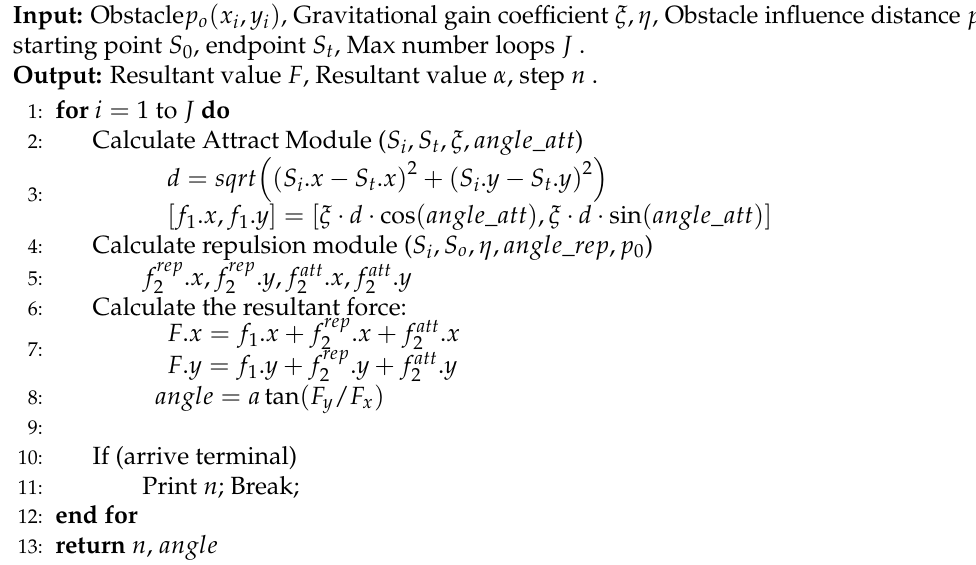
Algorithm 1 Artificial Potential Field Method.